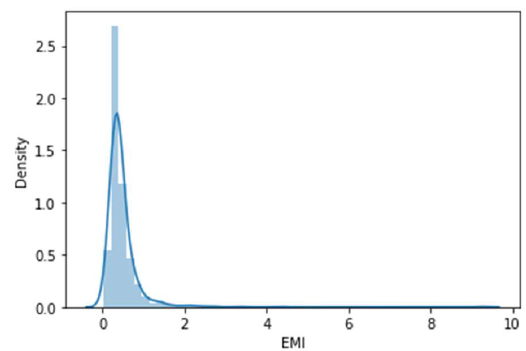
Fig. 2. Density vs EMI